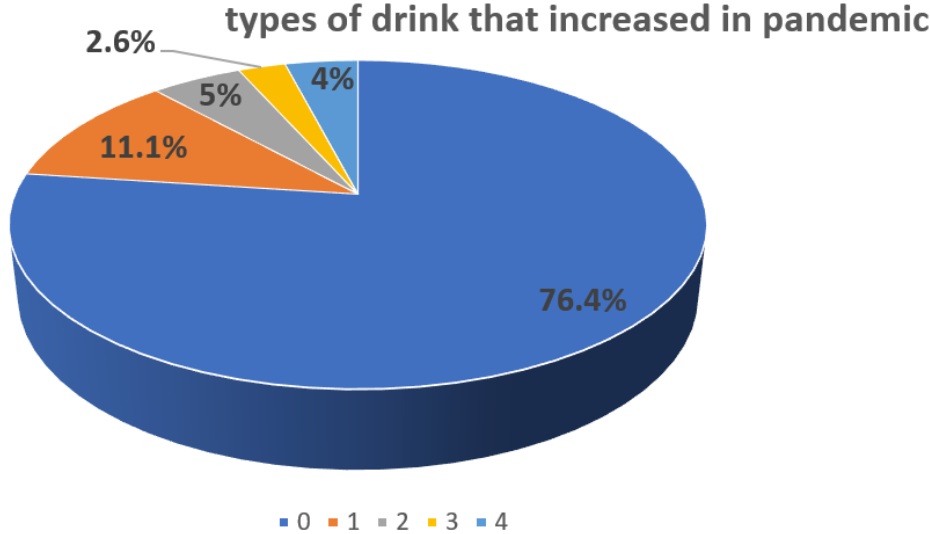
Figure 1. Variability in the type of drink that increased in pandemic divided into categories 0—no changes (76.4%), 1—water (11.1%), 2—coffee and tea (5%), 3—carbonated acid beverages (2.6%), 4—alcohol beverages (4%).